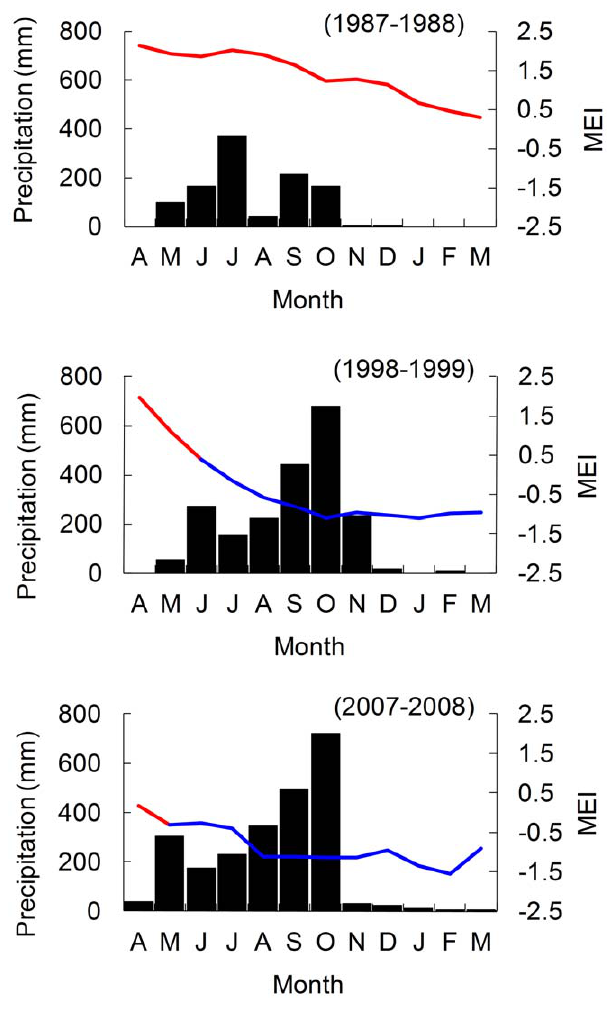
Figure 1. Monthly distribution of precipitation in Liberia, Costa Rica. Precipitation is highly variable between years of El Nin˜o (1987– 1988) and La Nin˜a (1998–1999, 2007–2008). The Multivariate ENSO Index (MEI; solid line) indicates when the Pacific climate is in El Nin˜o (red) and La Nin˜a (blue) phases [34].